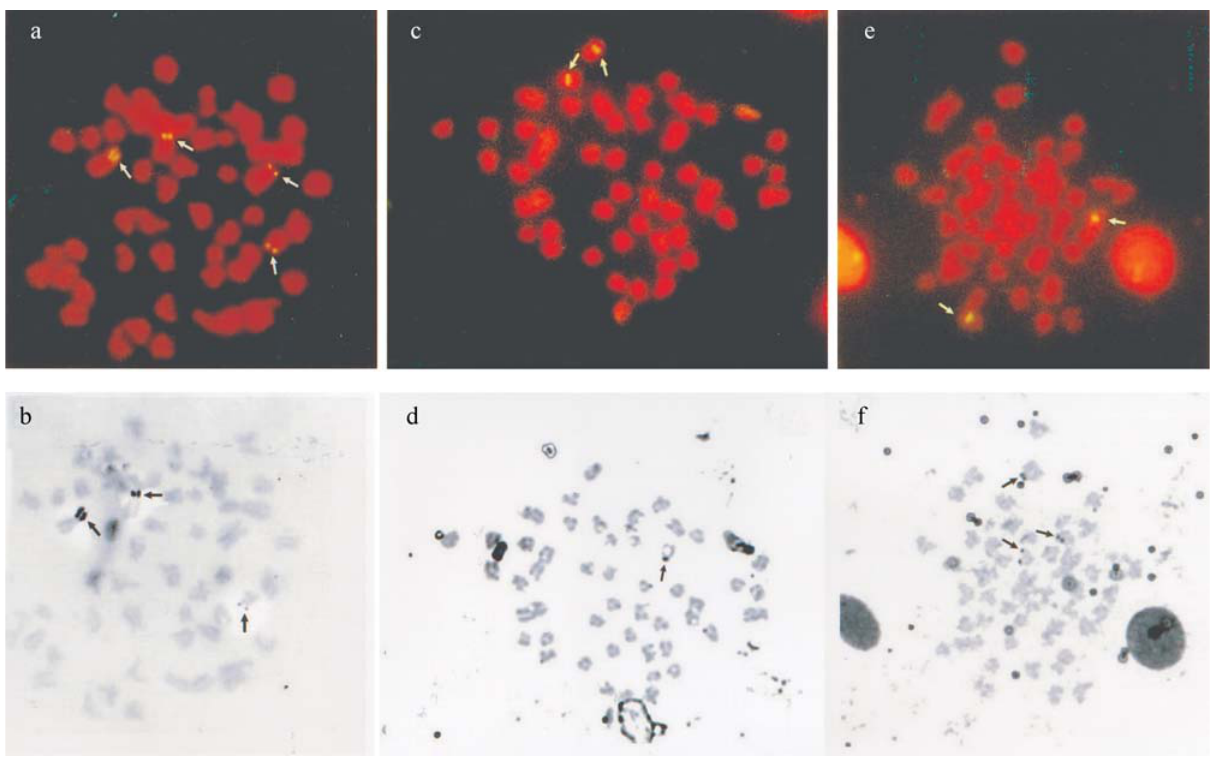
Figure 3 - Sequential Ag-staining of 18S-FISH (a, b) and 5S-FISH (c-f) slides. Specimens from the Tatupeba (a, b), Maringá (c, d) and Keçaba (e, f) streams. Note that the 5S rDNA loci do not lie on the same Ag-NOR